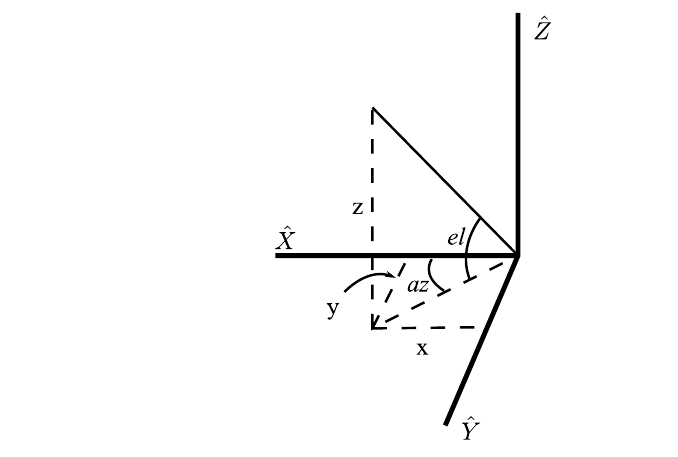
Fig. 3. Geometric representation of a pointing